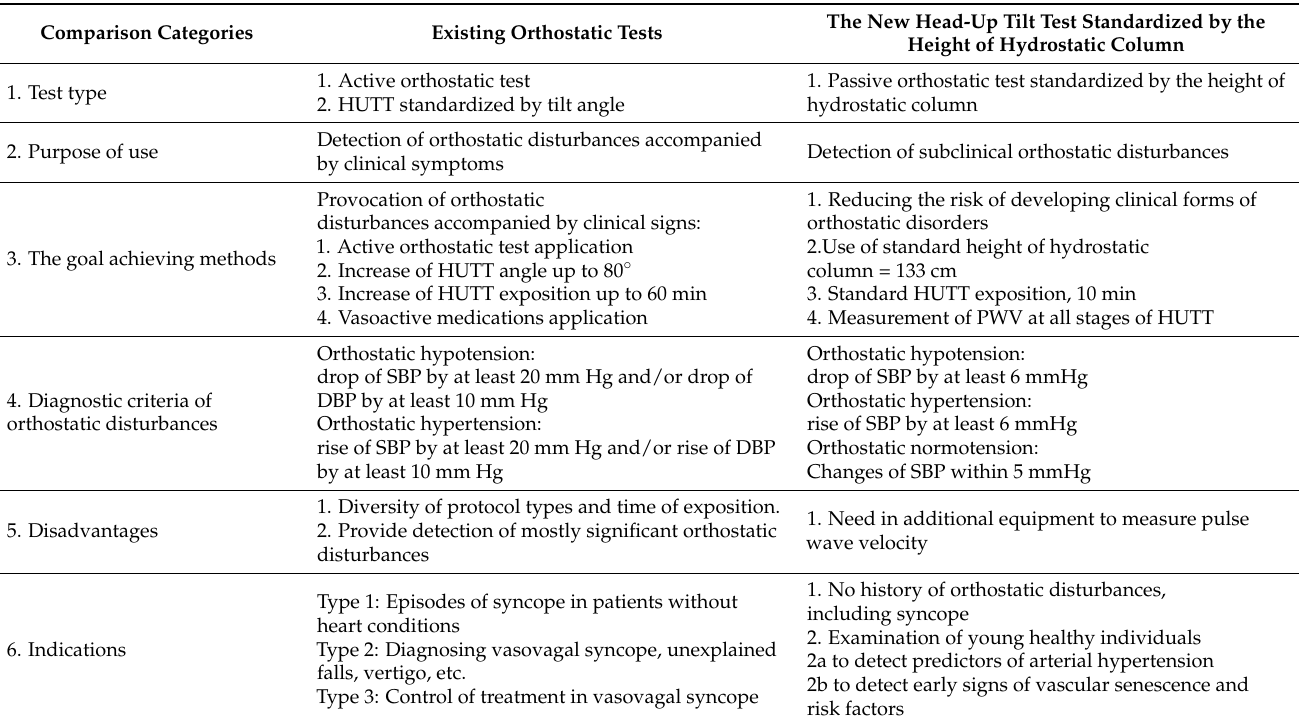
Table 3. Comparative characteristics of traditional protocols and the new HUTT protocol. standardized by the height of hydrostatic